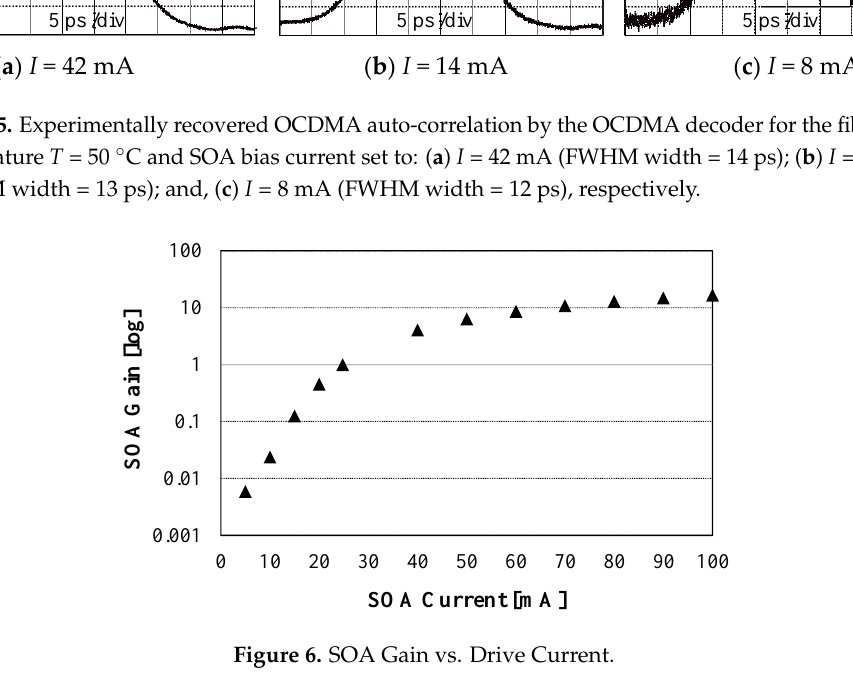
( c ) C = 1 Figure 7. Simulations of the recovered OCDMA auto-correlation envelope S L=19.5;T=50 for OCDMA code propagation distance L = 19.5 km, T = 50 ° C, and C equals to ( a ) 5 resulting FWHM width = 14.2 ps; ( b ) 3 resulting FWHM width = 13 ps; and, ( c ) 1 resulting FWHM width = 12 ps, respectively. Next, we have investigated the cumulative effect of the varying value of the transmission link GVD (parameter β 2 ) on OCDMA auto-correlation FWHM ’s relative changes for the code